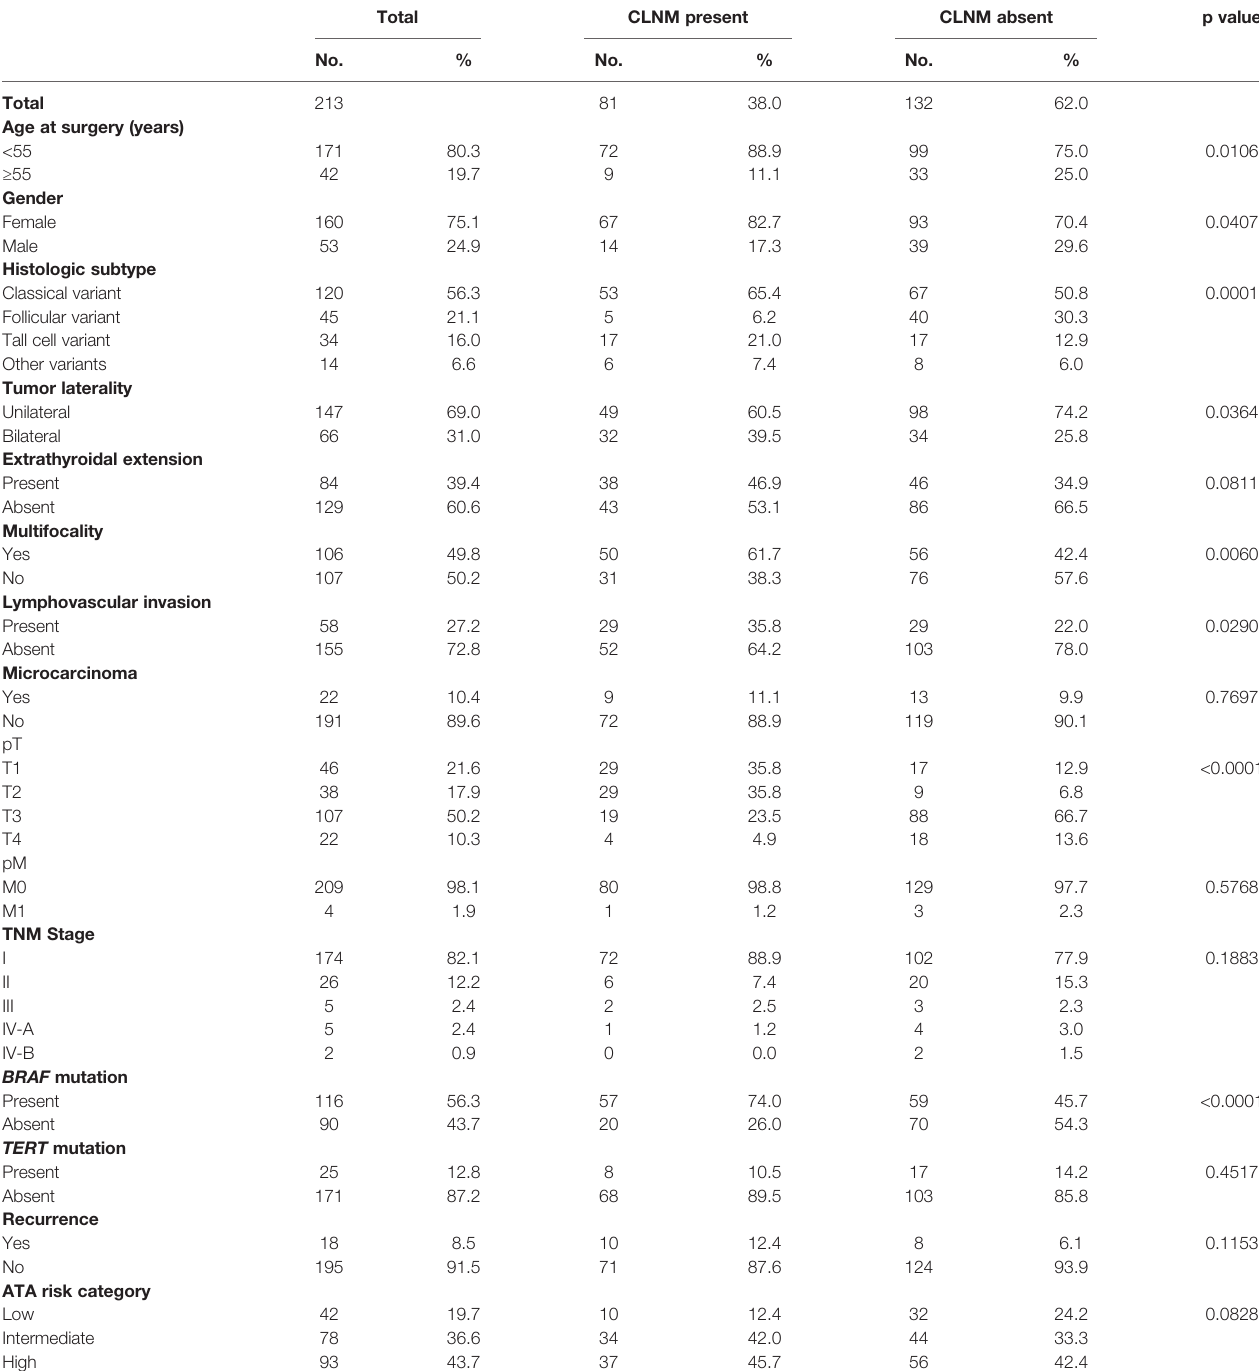
TABLE 2 | Clinico-pathological characteristics strati fi ed by central lymph node metastasis (CLNM) status in adult cN0 PTC patients who underwent prophylactic central lymph node dissection. Total CLNM present CLNM